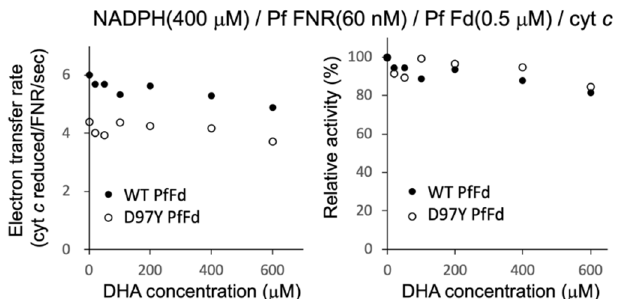
Figure 3. Electron transfer activity from PfFNR to wild-type (closed circles) and D97Y mutant (open circles) PfFds with different concentrations of DHA. The activity using cyt c as a final electron acceptor was measured in the absence and presence of DHA (20–600 µ M) under 400 µ M NADPH and 0.5 µ M Fds. The right figure shows the relative activity expressed as a percentage of the electron transfer rate when the rate in the absence of DHA was 100% for each Fd.